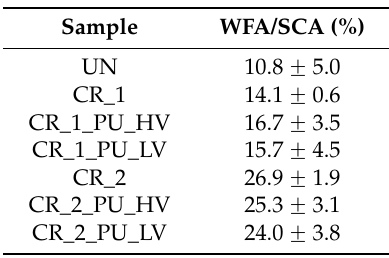
Table 2. Water front/sample cross-section area (WFA/SCA) ratios as calculated from the neutron radiography images after 4 h of exposure (Figures